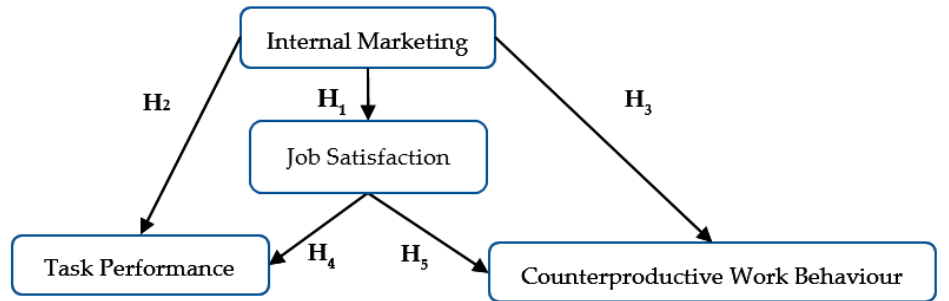
Figure 1. The influence of internal marketing on job satisfaction, task performance, and counterproductive work behavior.